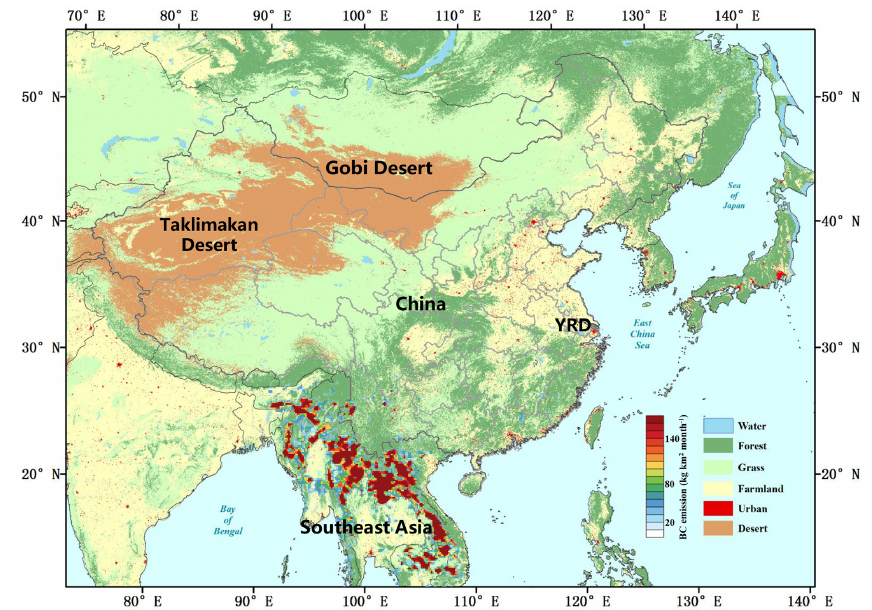
Figure 1. Map showing the land cover and averaged carbon emissions from biomass burning in March in East Asia. Note that the land cover data are the 2012 MODIS Land Cover Type product and biomass burning emission data are from the GFED4 emission inventory.